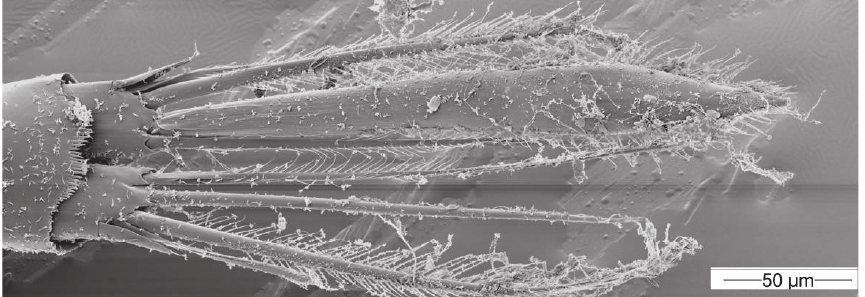
Fig . 5. – scanning electron micrograph of anal somite and caudal rami, ventral view showing modified spatulate caudal seta V on left side and slender unmodified seta on right side. Table 1. – swimming leg formula in the two morphotypes.